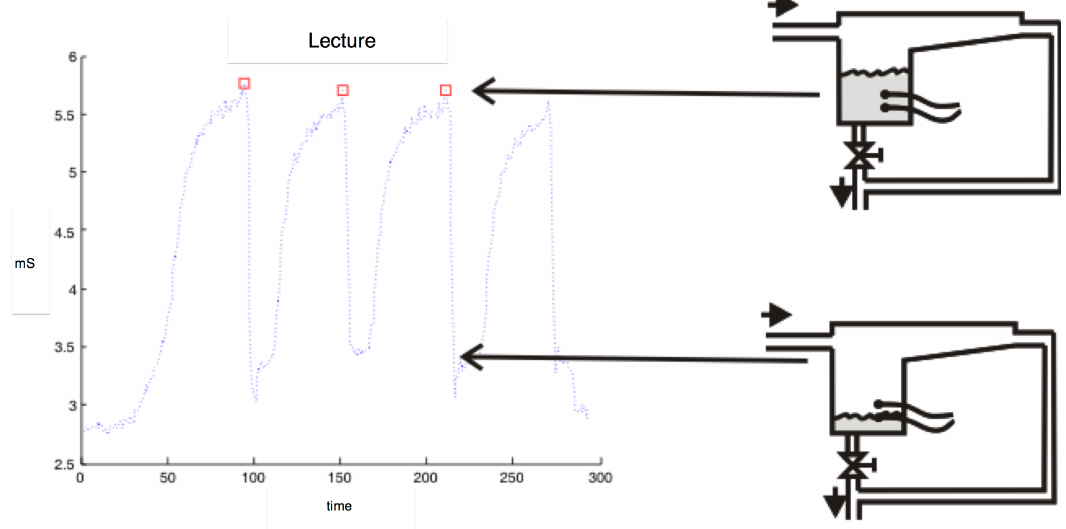
Figure 9. Scheme of the manual valve